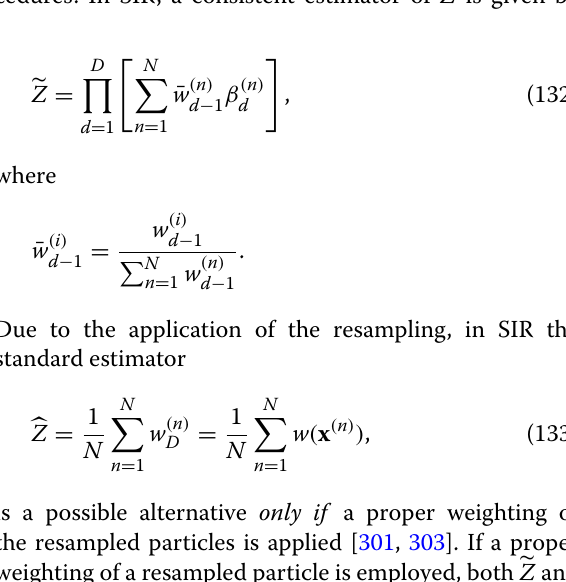
Algorithm 27. The PDF q λ ( λ | λ t − 1 ) denotes the